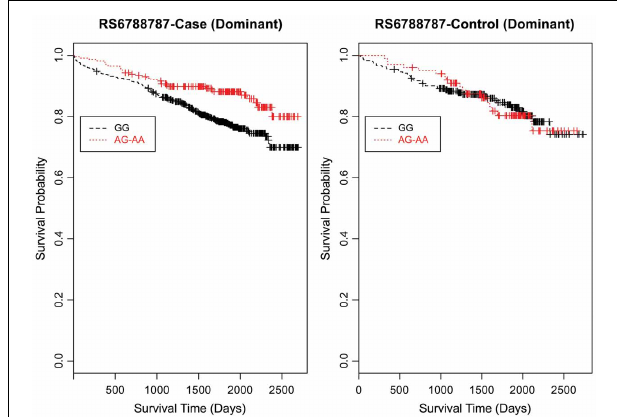
FIGURE 7 | Kaplan–Meier survival curves for CAD cases vs. controls in dominant (allele) model for LSAMP SNP rs1915585. X -axis displays the number of days from index catheterization to death (all-cause mortality). Y -axis displays the Kaplan-Meier survival probability by genotype. T is the minor allele; GG, wild-type genotype (reference; black curve); and red curve indicates GT and TT genotypes